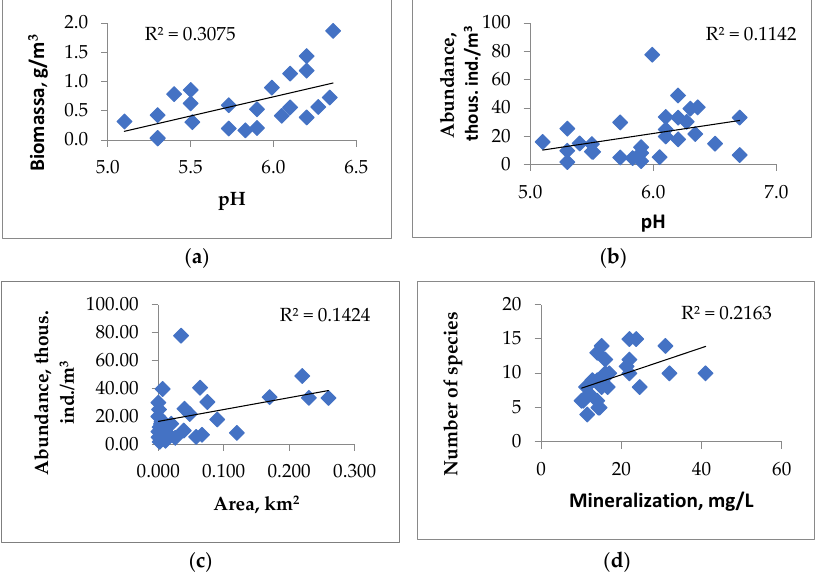
Figure 4. Biomass ( a ), abundance ( b , d ) and number of zooplankton species ( c ) depending on pH, mineralization and lakes area.